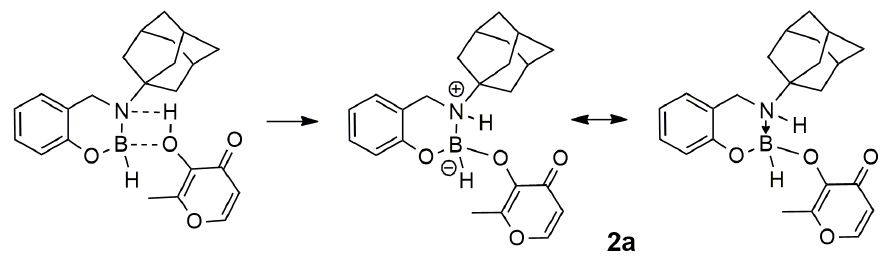
Figure 5. Formation of 2a